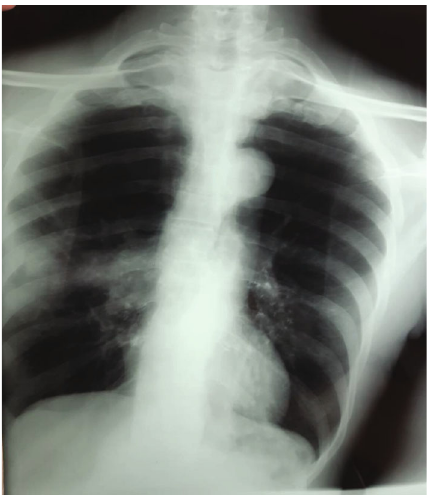
Figure 1: The posteroanterior chest roentgenogram showed homogeneous right hilar opacity with peripheral nodular opacity with spiculated contours.